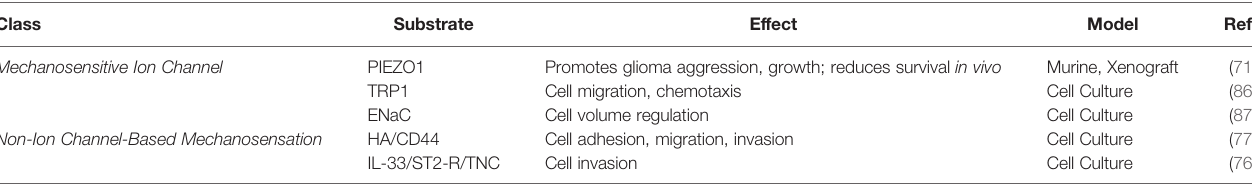
TABLE 1 | Representative Substrates of Mechanical Signal Transduction in Glioma. Class